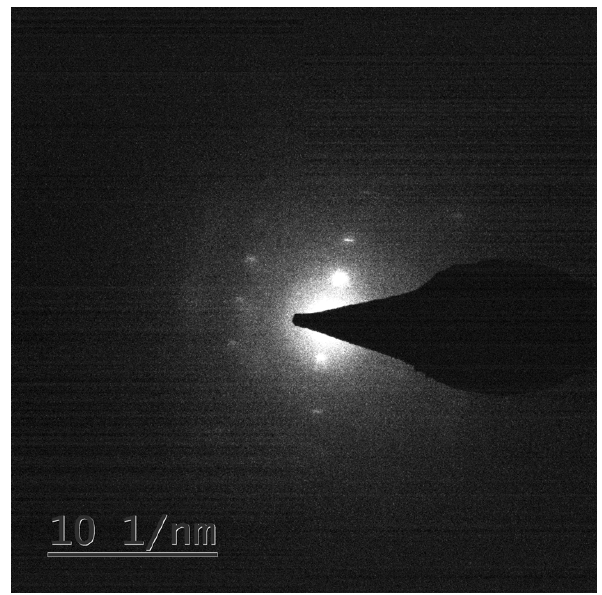
Figure 1. Kikuchi pattern obtained from the extracted pigment from S. cuboideum with an FEI Titan 80–200.